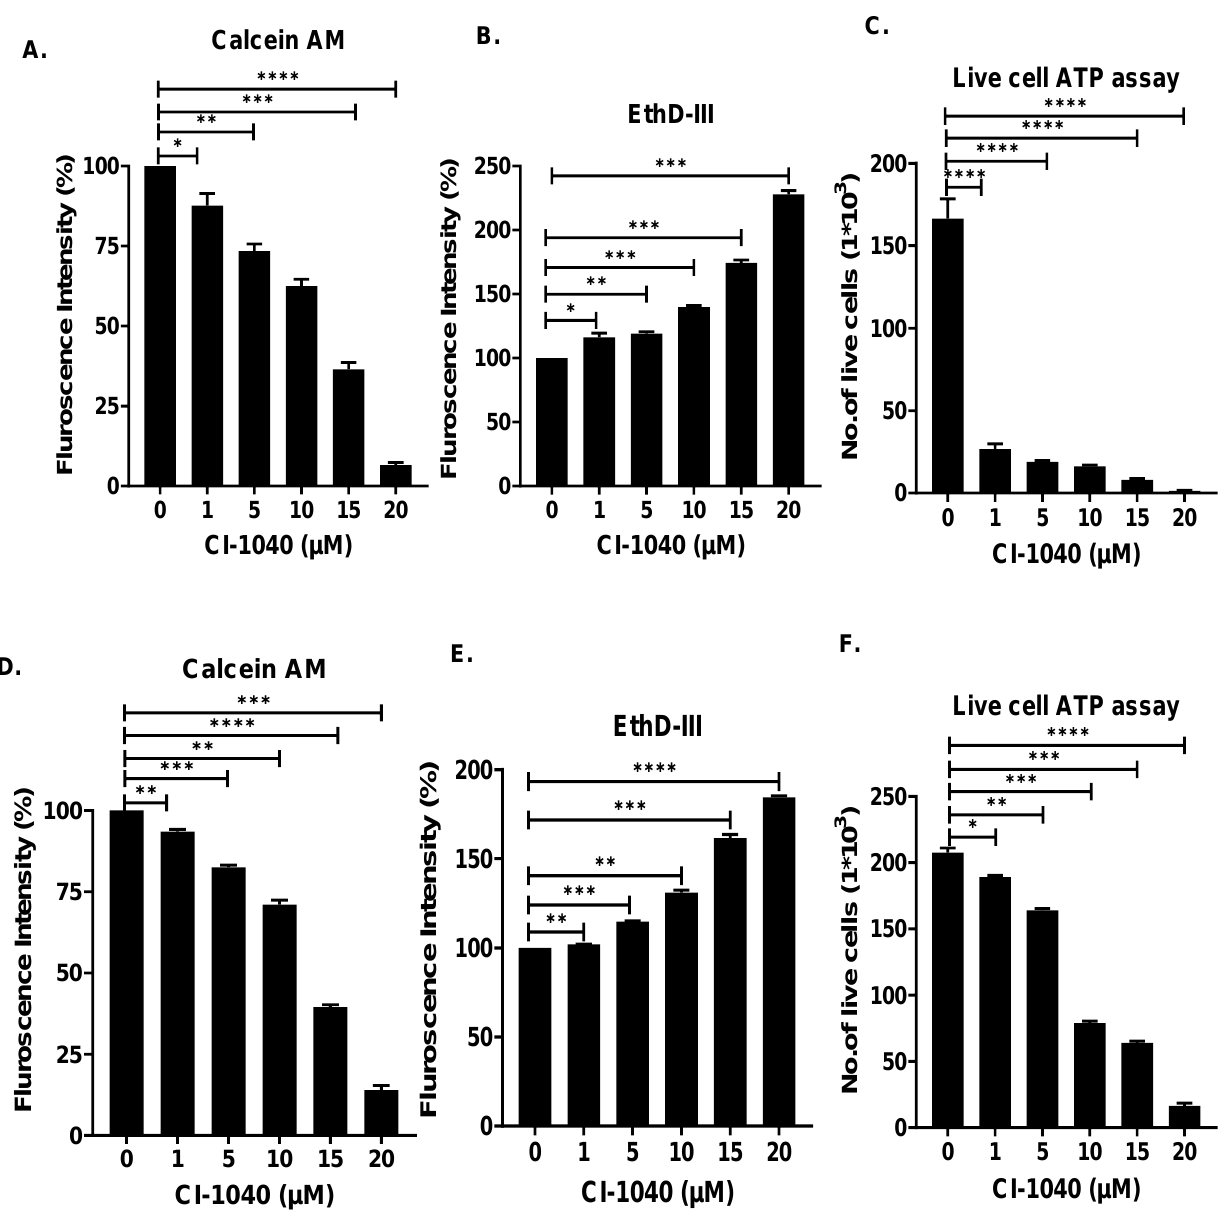
Figure 6. CI-1040 directly inhibits NB spheroidal live cells. NB 3D spheroid in Figure 5 were further analyzed for the effect of CI-1040 on tumor cell viability. ( A , D ) Quantitation of the percentage of live cells on final day (day 15) spheroids stained with Calcein AM ( A ) SH-SY5Y ( D ) IMR-32. ( B , E ) Quantitation of the percentage of dead cells stained with EthD-III. ( B ) SH-SY5Y ( E ) IMR-32. ( C , F ) Quantitation of the number of live cells using a live cell ATP release assay ( C ) SH-SY5Y ( F ) IMR-32. * p < 0.05, ** p < 0.01, *** p < 0.001, and **** p <